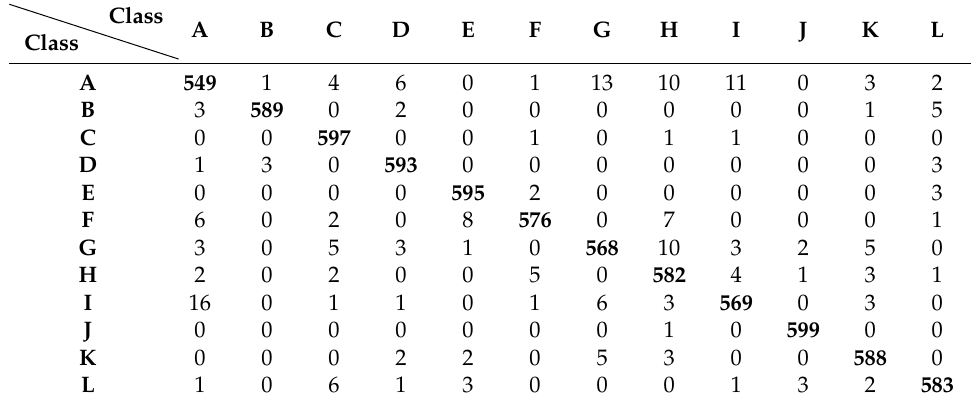
Table 7. Classification result after combination using Sum rule.